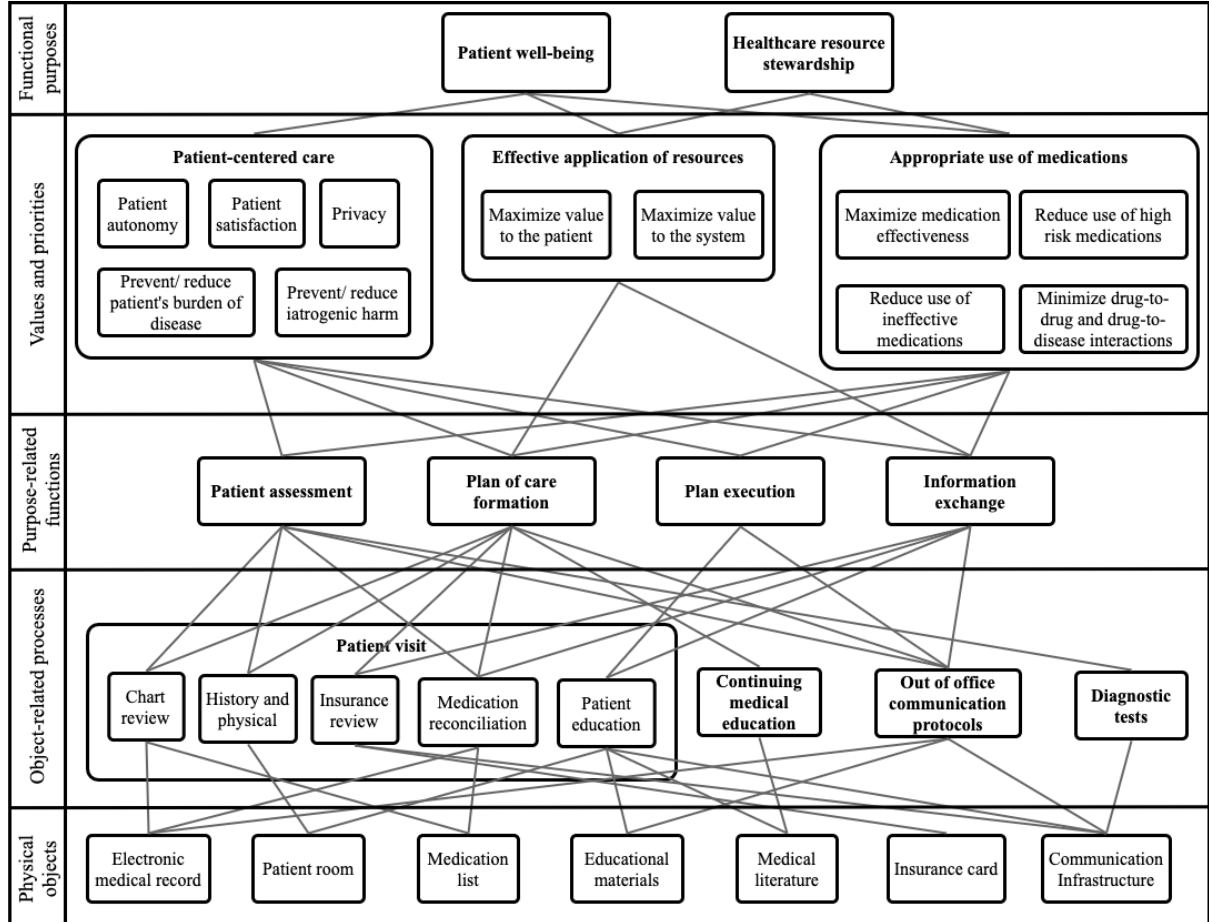
Figure 1. Abstraction Hierarchy of the medication management system in primary